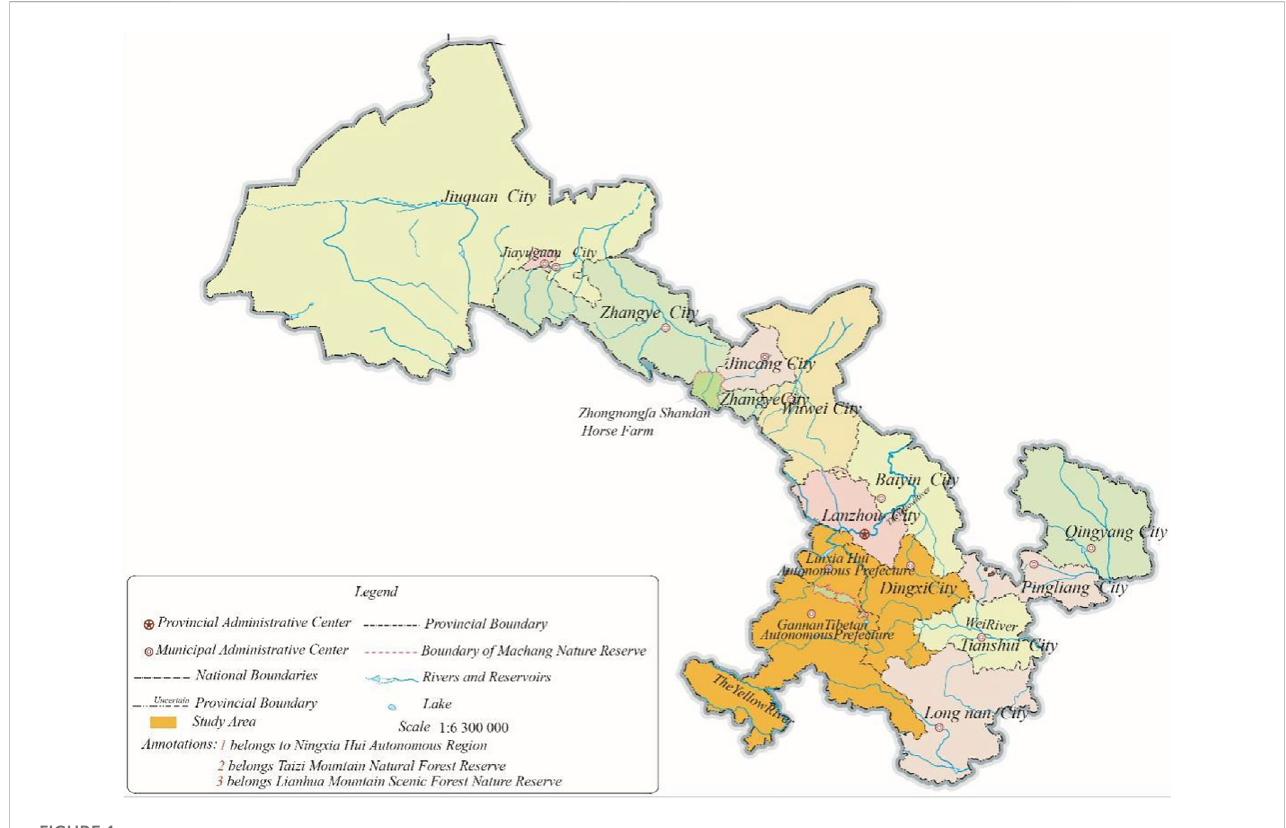
FIGURE 1 Map of Gansu